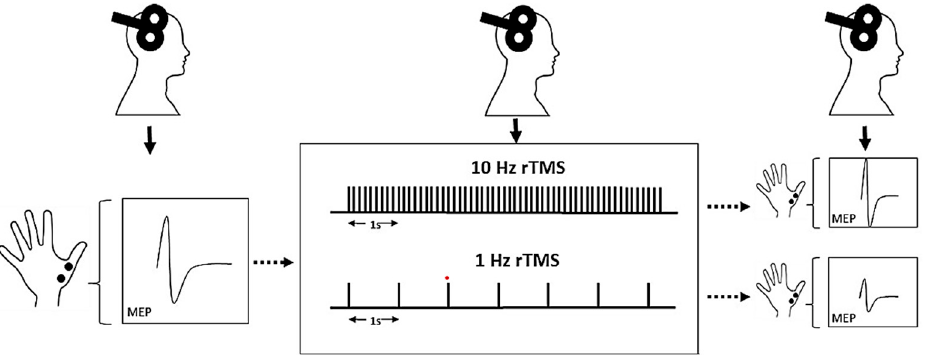
Figure 3. Basic protocols and main effects induced by rTMS. MEP: motor evoked potential. Modified